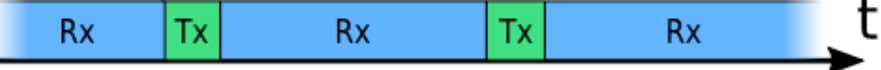
Figure 3. Transmission waveform for a Class C node (own source).